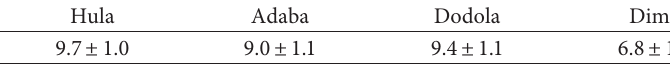
Table 1: The moisture contents (% w/w) of the air-dried leaf samples of Urtica simensis .